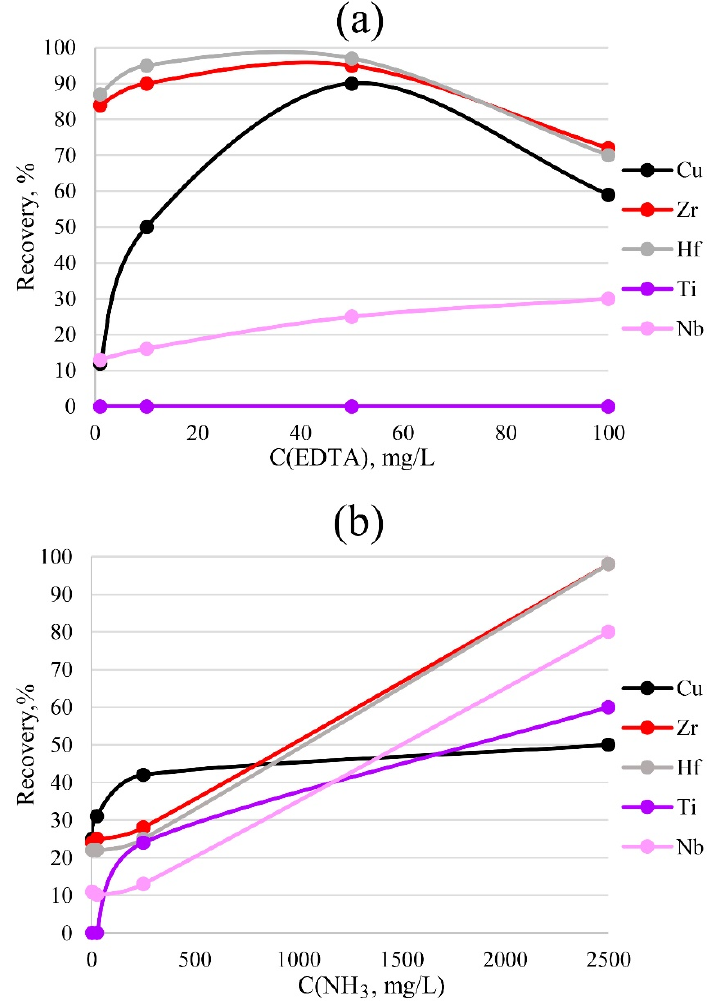
Figure 7. Dependence of recovery on the concentrations of EDTA ( a ) and ammonia ( b ). Sorption conditions: 0.1 mol/L HCl, m PTE = 0.1 g, V liquid phase = 10 mL, t = 1 h, T = 60 °C, C analytes = 1 mg/L.